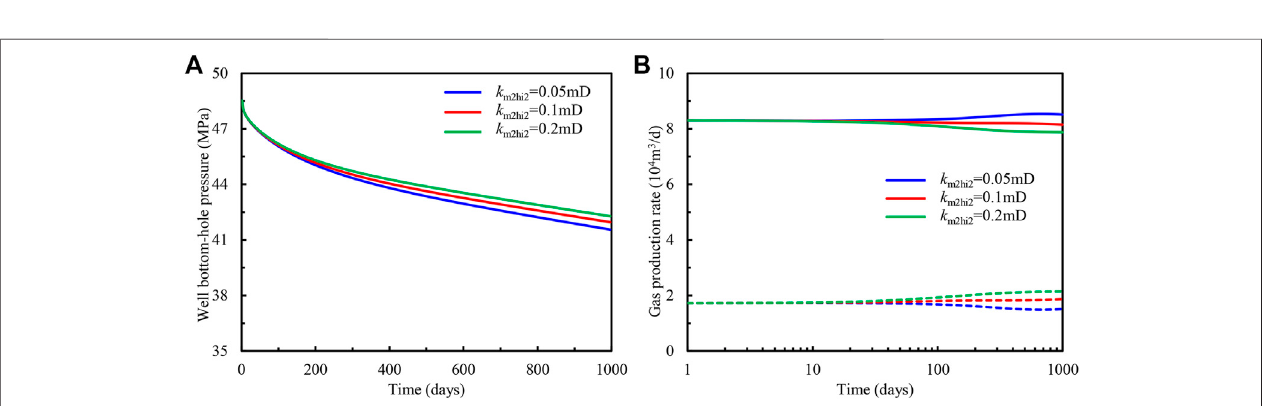
FIGURE 10 | In fl uence of horizontal permeability of matrix in the second layer on (A) bottom-hole fl owing pressure and (B) gas production of individual formation.